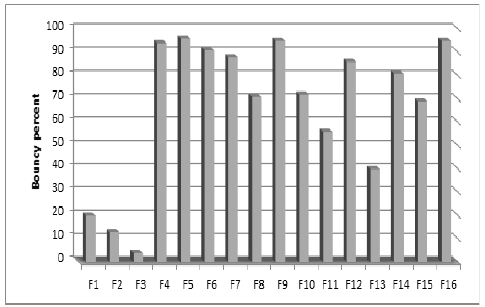
Figure 6. Bouncy percent of ITZ